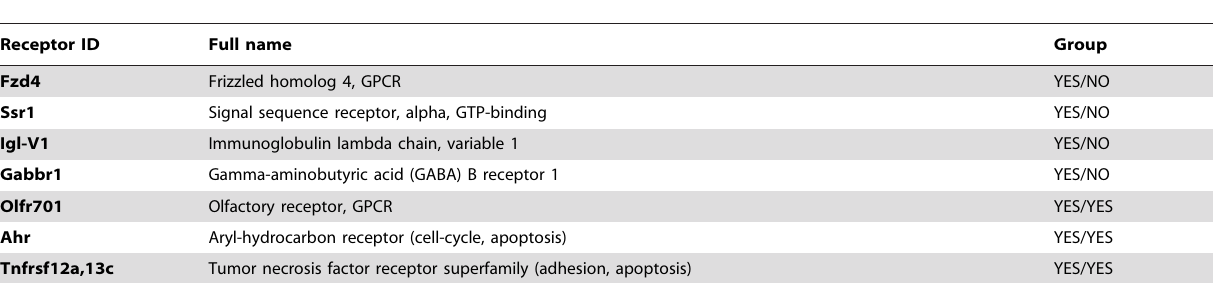
Table 1. Receptor genes expressed in YES/NO and YES/YES sub -regions of B-Cell.